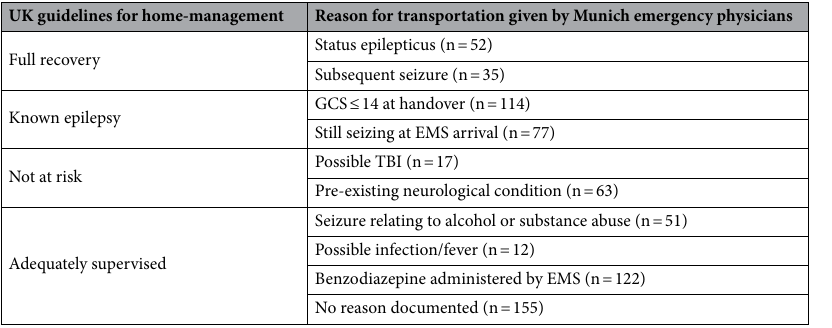
Table 2. UK Criteria for home management and corresponding reasons for hospitalization given by the emergency physicians in Munich. “Pre-existing neurological condition” includes brain tumor and metastases, intracranial hemorrhage and malformations as well as infantile brain damage and stroke. TBI Traumatic Brain Injury, GCS Glasgow-Coma-Scale, EMS Emergency Medical Service, n/a not